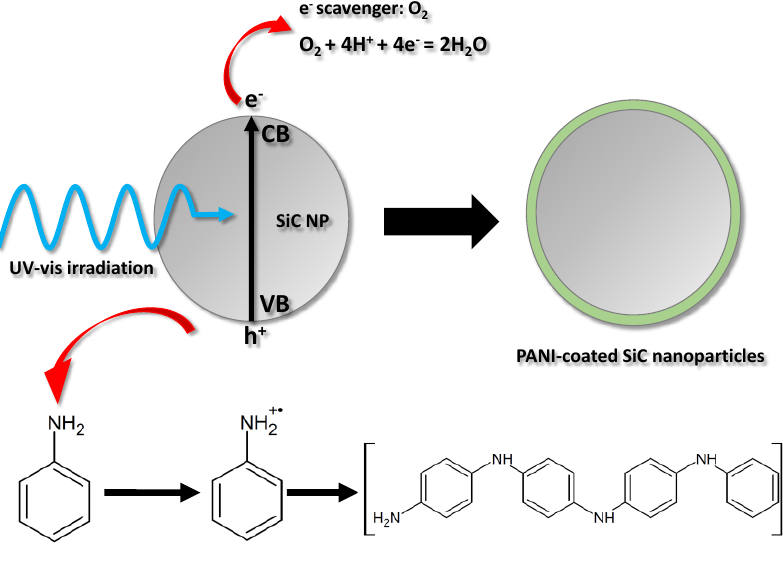
Figure 1. Schematic illustration of the nanocomposite synthesis.